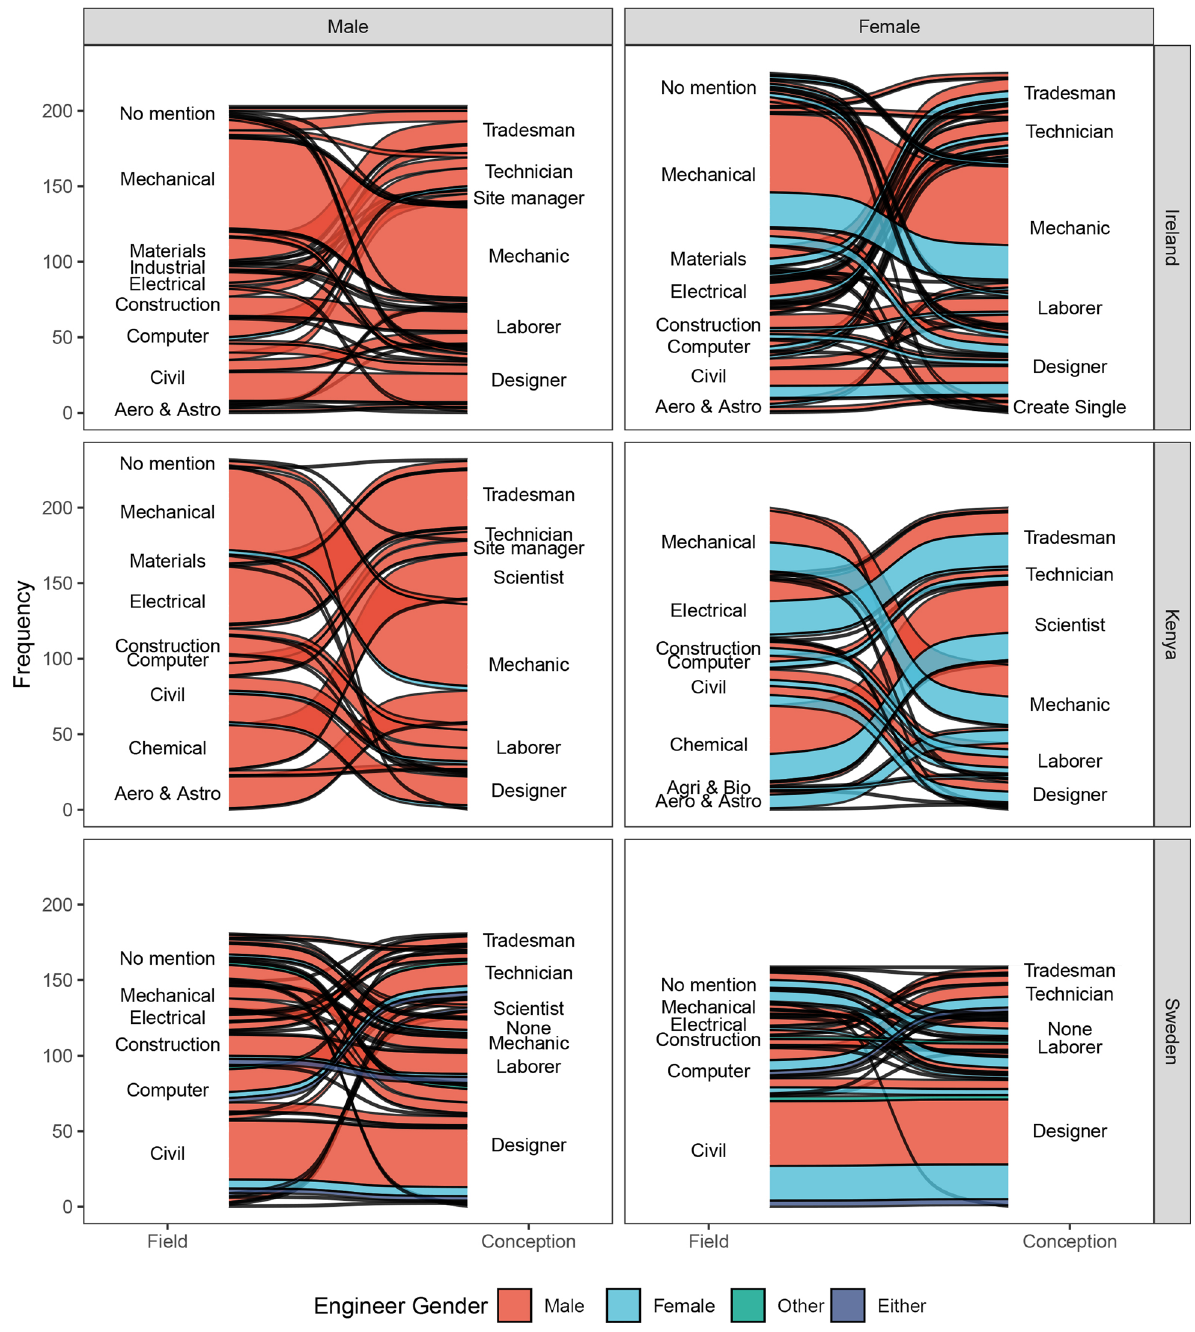
Fig. 2 Sankey diagrams depicting the associations made by male and female Irish, Kenyan, and Swedish students between genders of drawn engineers, fields of engineering and conceptions of engineering work. Engineering fields and conceptions are not labelled if there are fewer than 5 instances. Y axes illustrate raw frequencies. The raw data for each panel are described in Additional file 1: Table S1, Additional file 2: Table S2, Additional file 3: Table S3, Additional file 4: Table S4, Additional file 5: Table S5, Additional file 6: Table S6, available at: https:// osf. io/